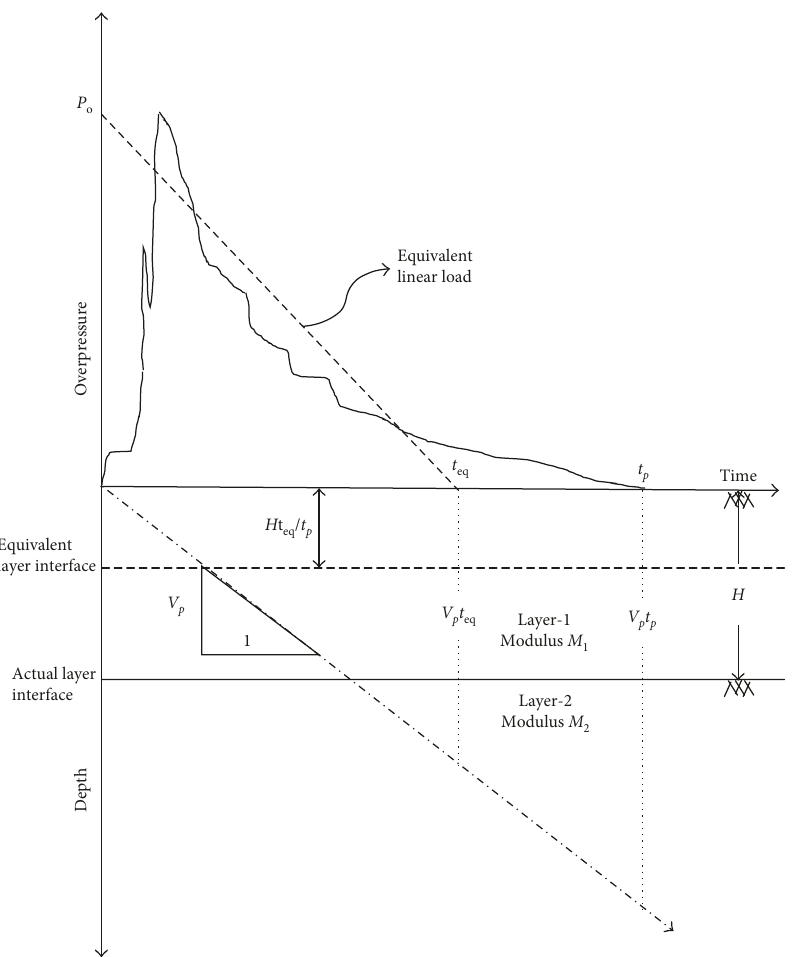
Figure 3: Scaling of equivalent ground